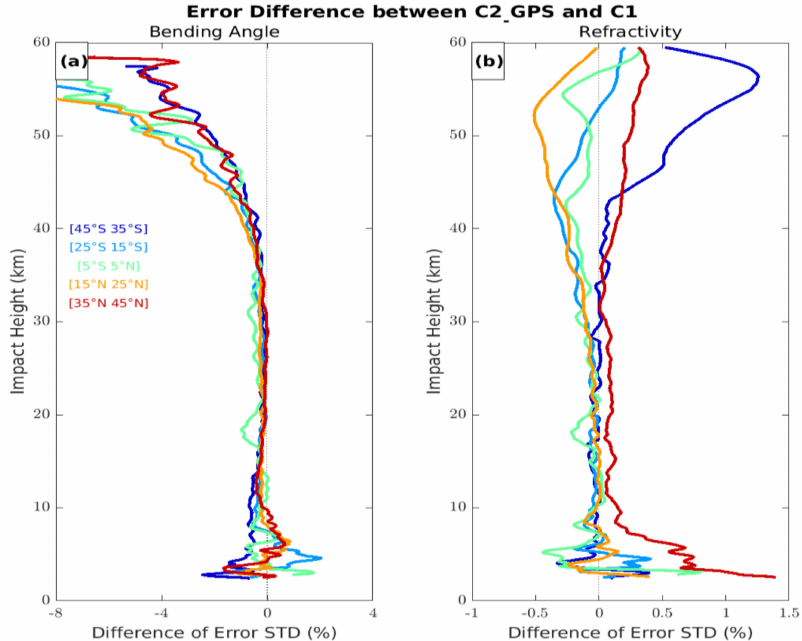
Figure 11. Differences in 3CH error STD of C2 (GPS only) minus C1 for bending angle ( a ) and refractivity ( b